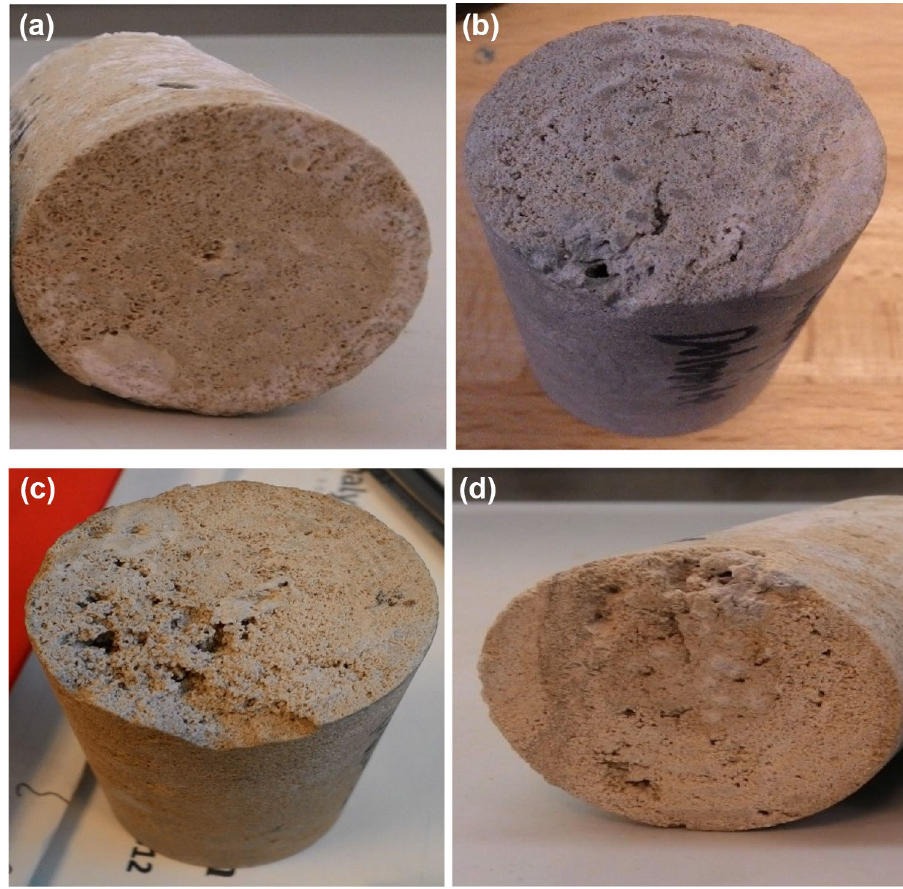
Fig. 9 Photographed